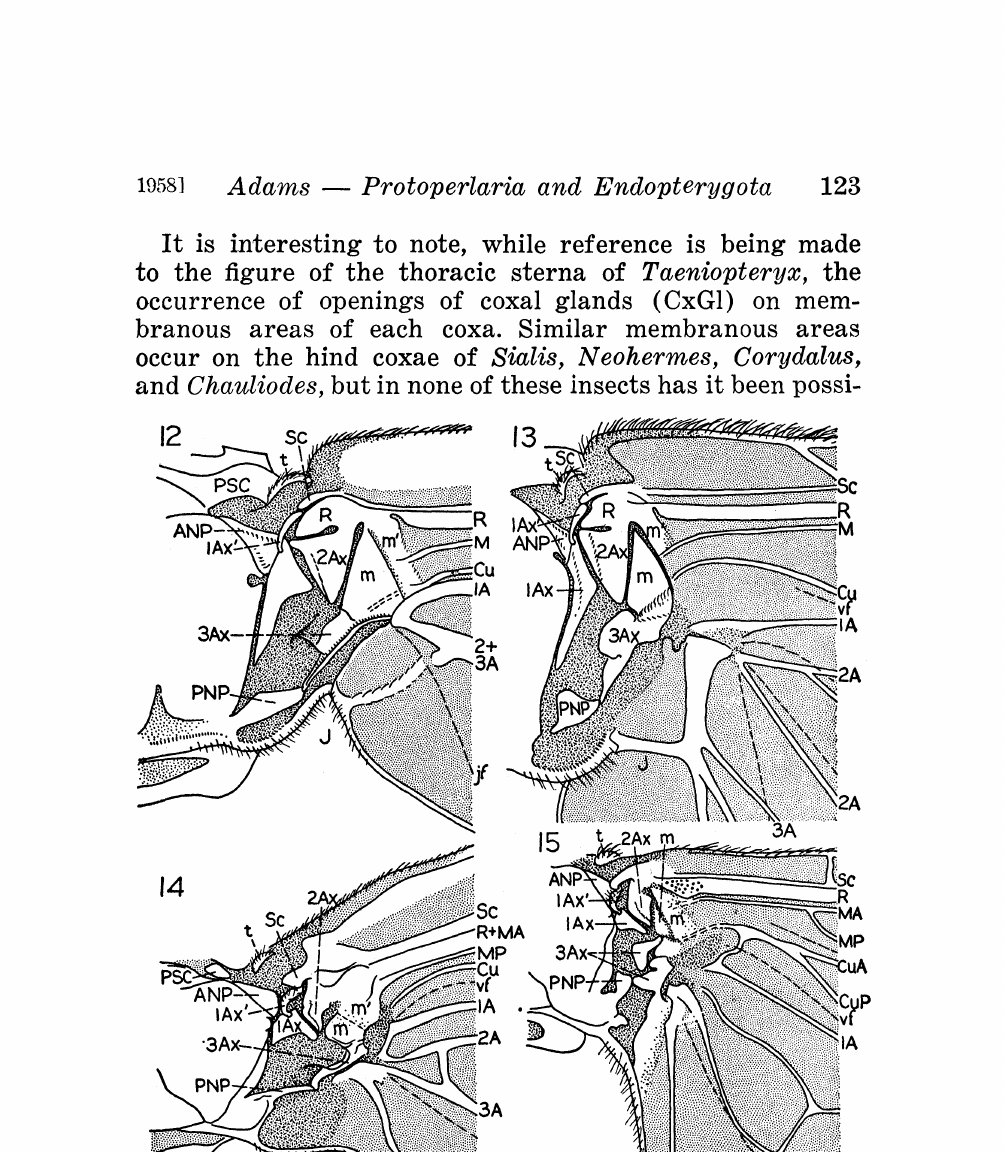
Figure 13. P. cali]ornwa. Base of posterior wing. Figure 14. Neohermes cali]ornicus (Walk.) (Megaloptera). Base of anterior wing. Figure 15. N. cali]ornicus. Base of posterior